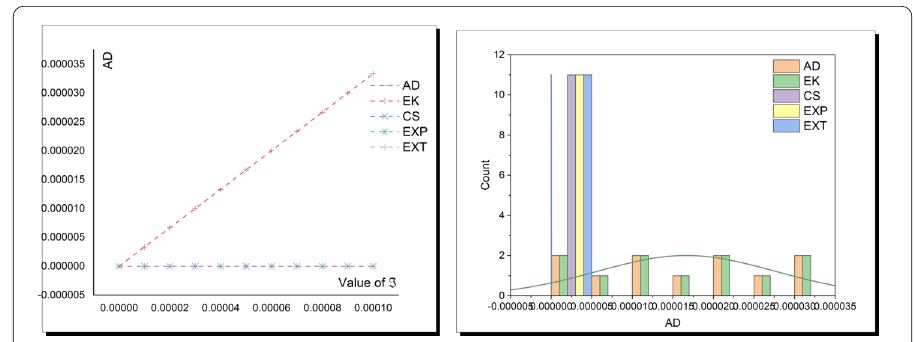
Figure 6 Two-dimensional sketches for the above-used